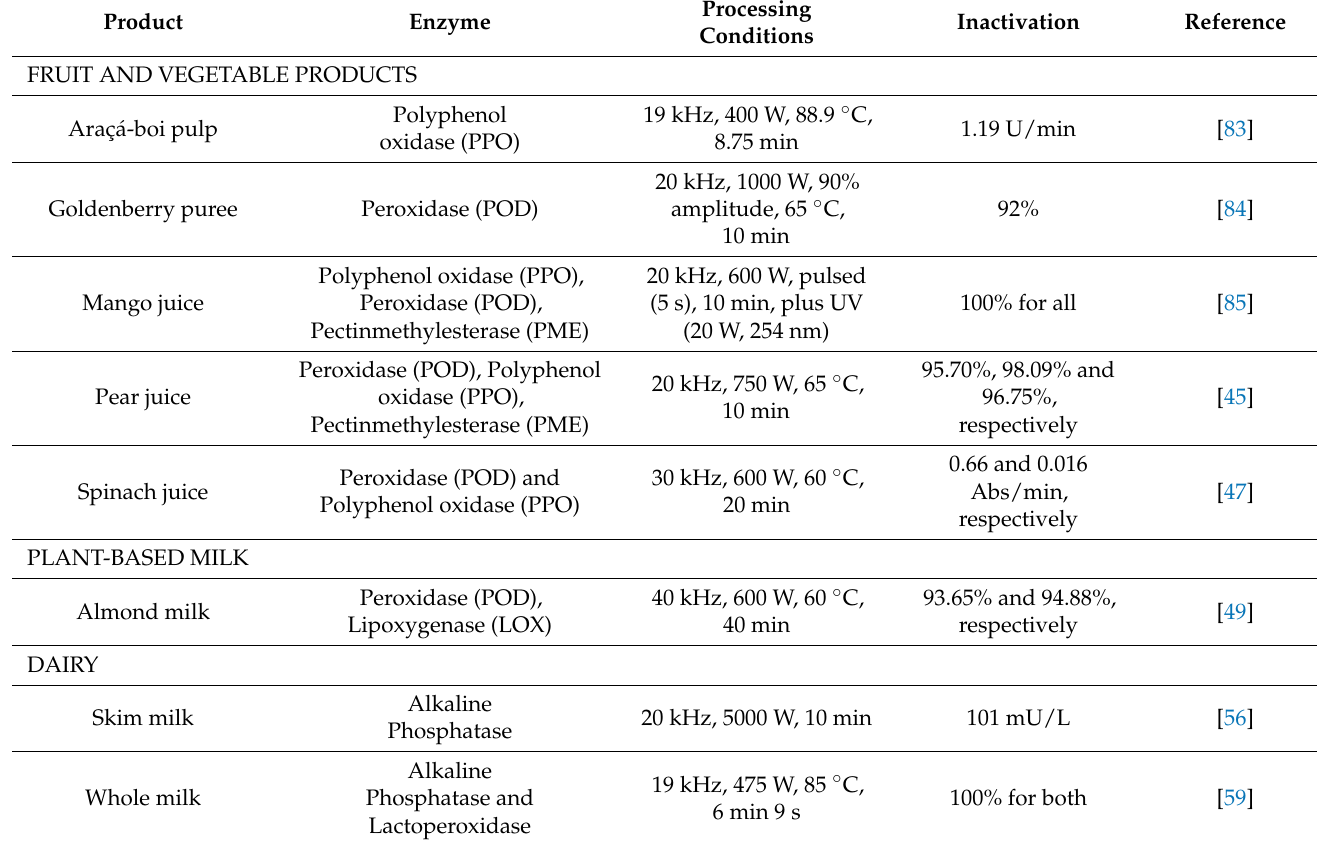
Table 2. Enzyme inactivation in selected food products by